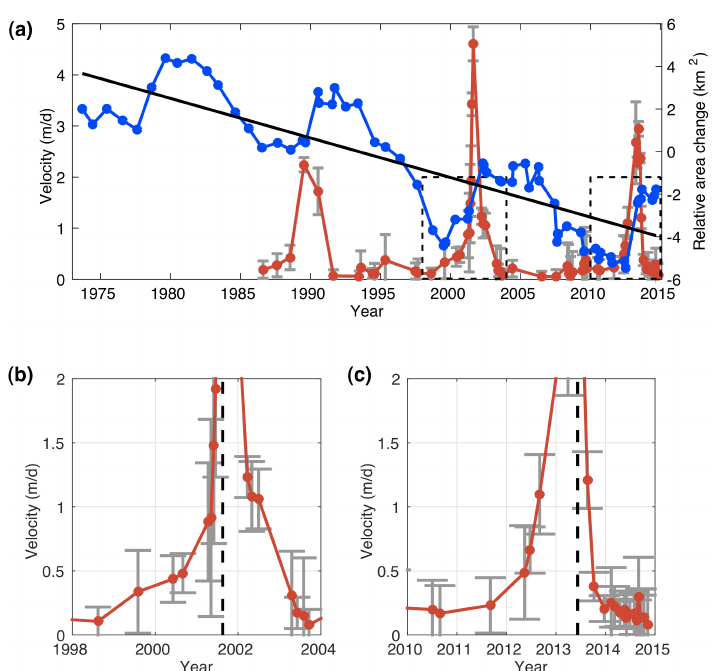
Figure 2. Ice speeds and area near the terminus. (a) Temporal changes of the ice speed (red) and the terminus area (blue). The ice speed data are averaged over the section between 0 and 5km along the flow line shown in Fig. 1a. The error bars indicate the mean speed in the non-glacial region. The black line indicates the long-term change of the terminus area. The dotted line boxes mark the areas shown in (b) and (c) . (b) Temporal change of the ice speed associated with the 2001 event. (c) Same as (b) except for the 2013 event. The black dotted line marks the peak in ice speed during each event.